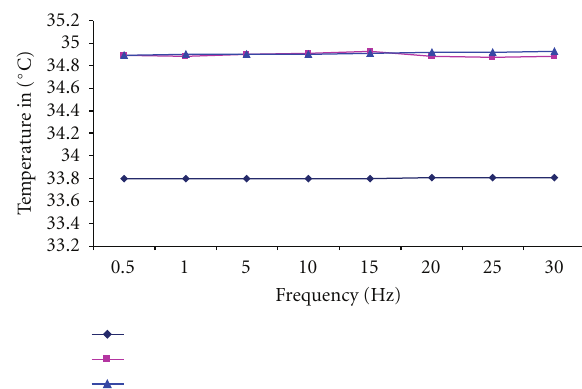
Figure 27: Ambient temperatures at which the tests were carried